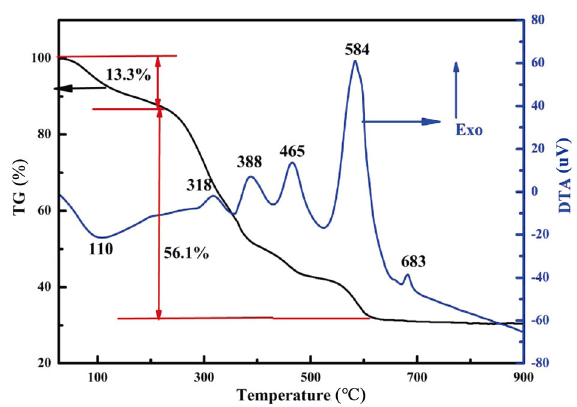
Fig. 2 TG and DTA curves of the dried gel obtained by the stearic acid method.